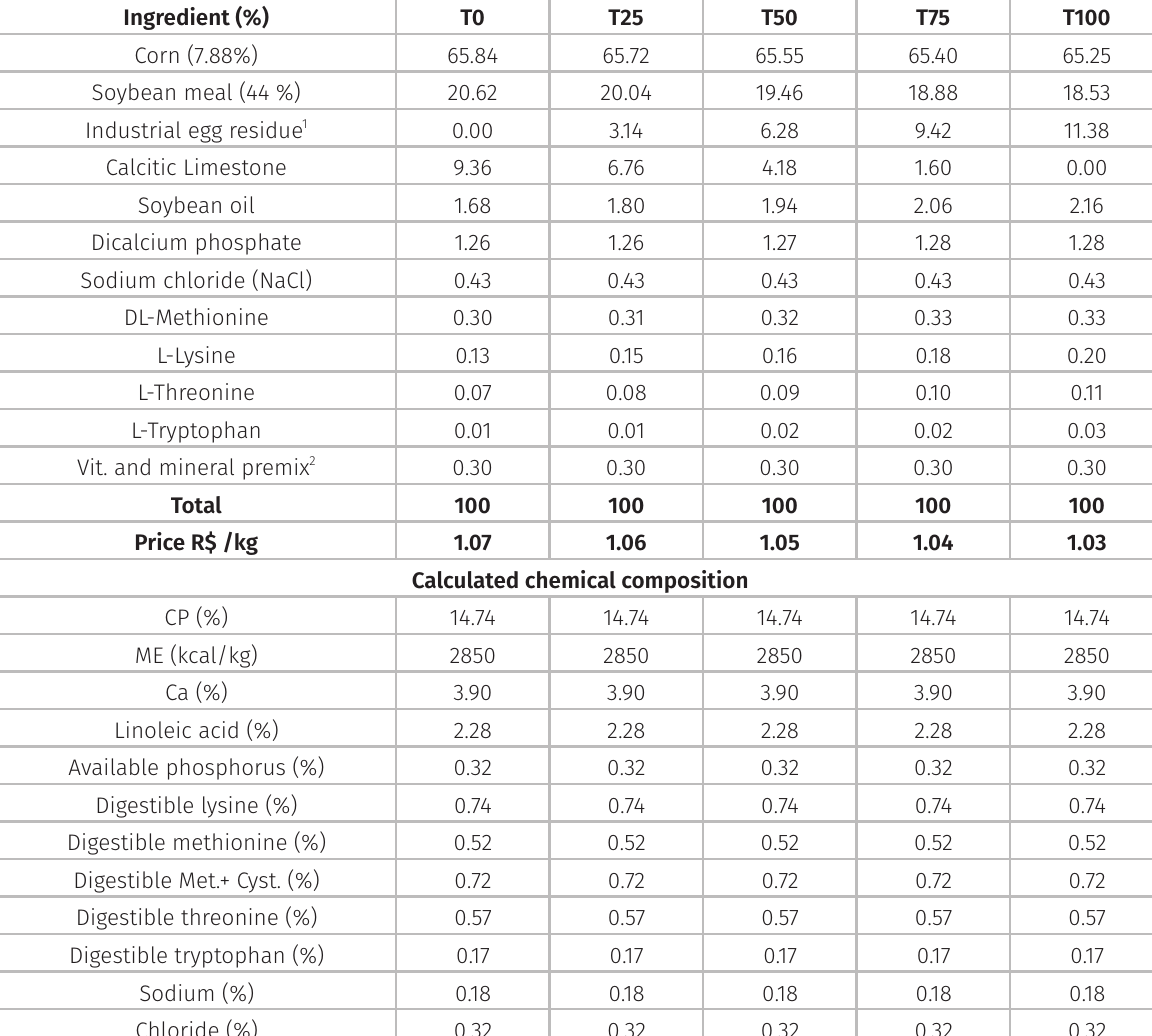
Table II. Ingredients, diet cost and chemical composition calculated from each experimental diet used in this study with different levels of replacement of industrial egg residue with calcic limestone: Experiment